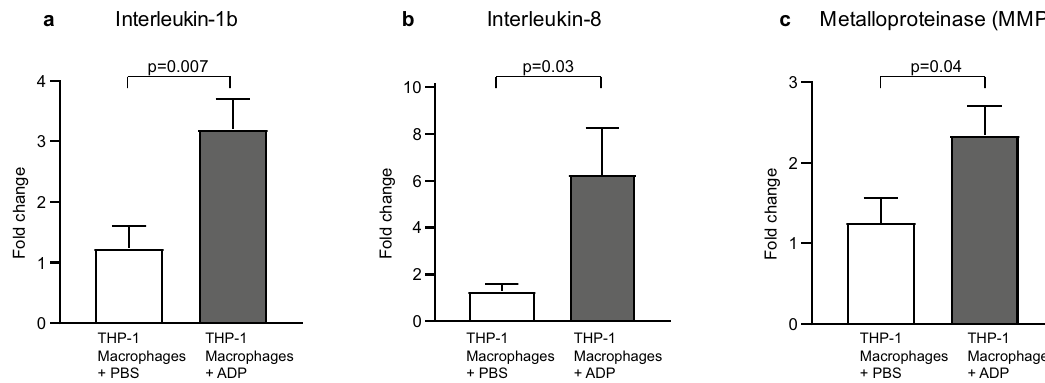
Figure 5. ADP stimulation induces expression of pro-inflammatory genes in P 2 Y 12 receptor expressing THP-1 macrophages. Stimulation of THP-1 macrophages with ADP or PBS, RNA isolation and qRT-PCR with primers for IL-1b, IL-8 and MMP-9 was performed as described in the “Methods” section. ADP stimulation resulted in upregulation of the pro-inflammatory genes such as IL-1b ( a ), IL-8 ( b ) and MMP-9 ( c ). Fold change of expression in relation to the housekeeping gene is presented as 2 -∆Ct and p -values were calculated by an unpaired Student’s t-test, n = 3. Data are presented as mean ±